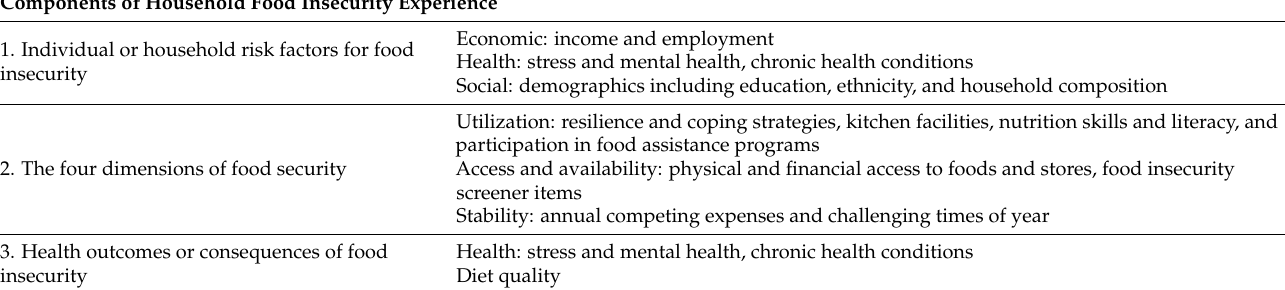
Table 2. The three components of the household food security experience—a conceptual basis for comprehensively measuring household food security in families with young children and preg- nant